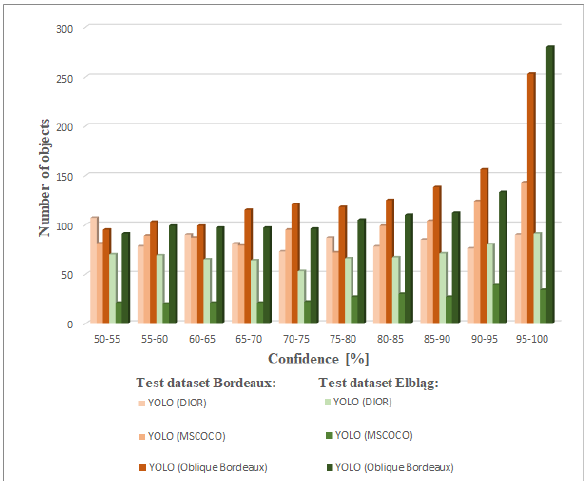
Figure 7. Plot of the dependence of the number of objects on the confidence with which were detected - for the Elblag (green colours) and for the Bordeaux (red colours) test sets.